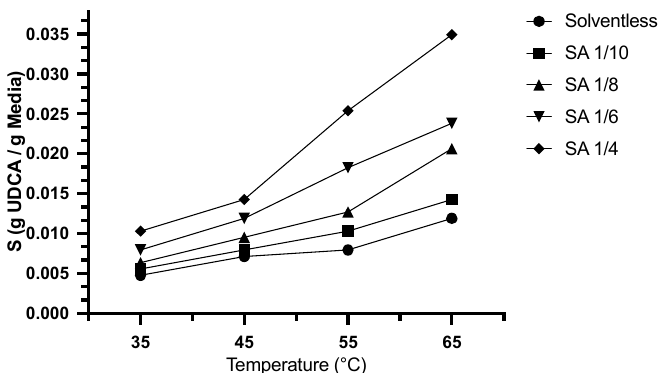
Figure 1. Solubility of UDCA in solventless and solvent-assisted conditions.